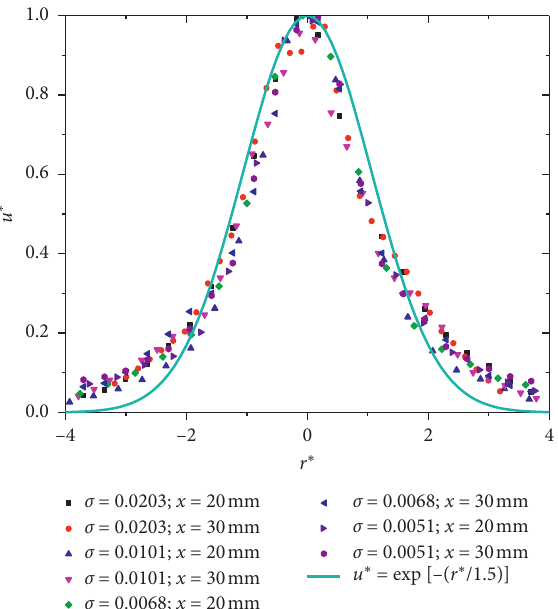
Figure 17: Normalized velocity along the radial direction under different cavitation